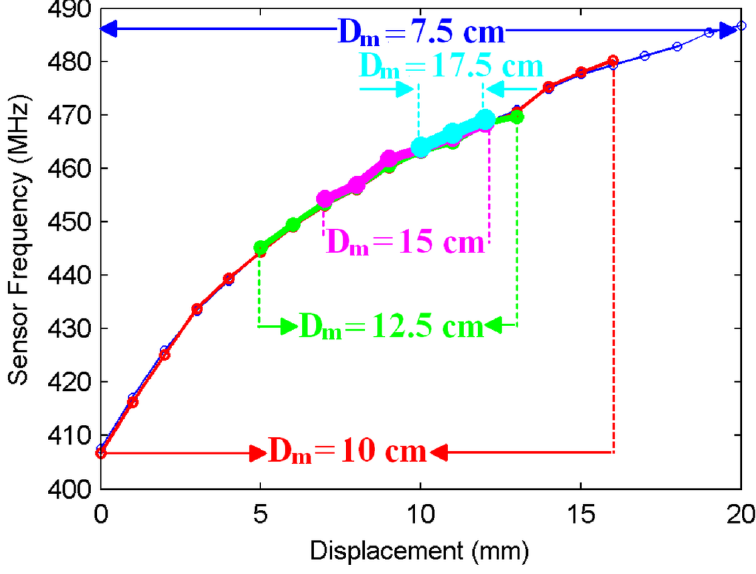
Figure 4. Displacement tracking range plotted for different monitoring distances D (the distance between the antenna and the NSRR probe) at a tracking threshold of 1 dB. The tracking range diminishes as D is increased. m